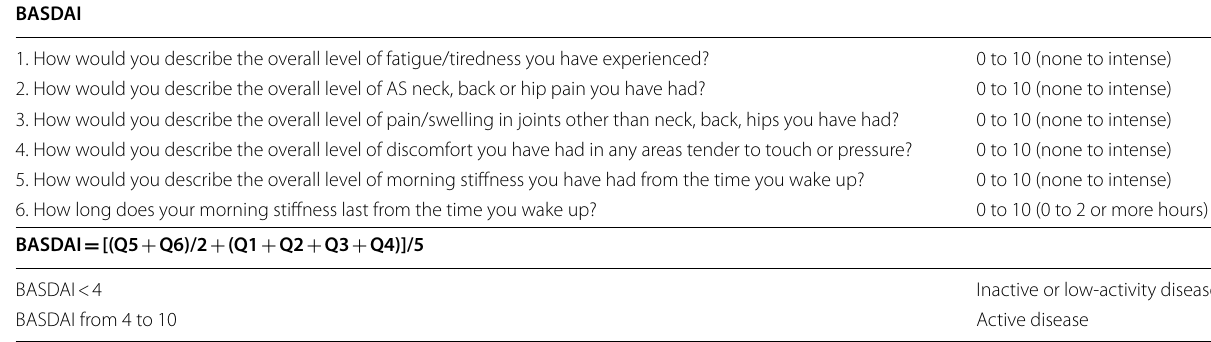
Table 3 BASDAI assessment criteria for axial inflammatory activity in spondyloarthritis [8, 199] BASDAI